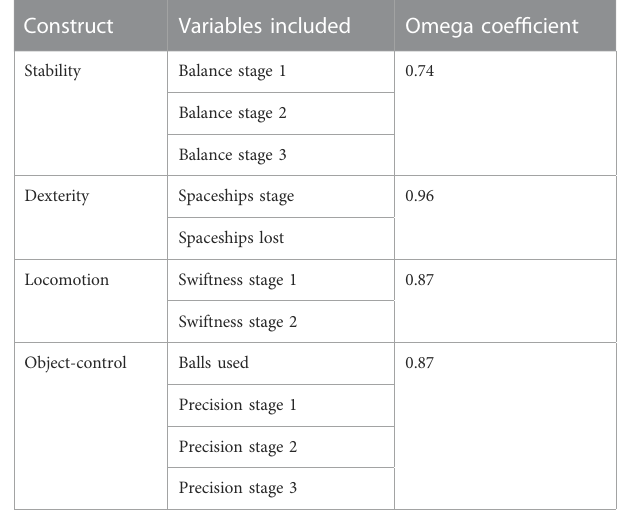
TABLE 1 Internal consistency reliability of the four GMCA